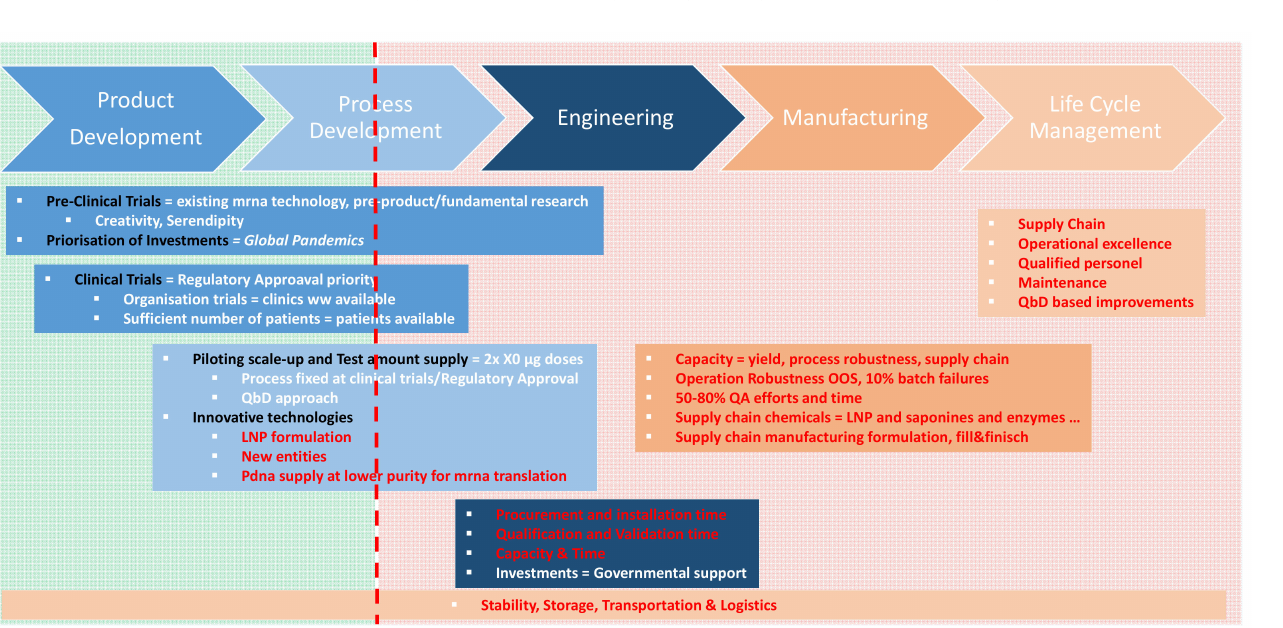
Figure 1. Typical SWOT analysis of bottlenecks, challenges &